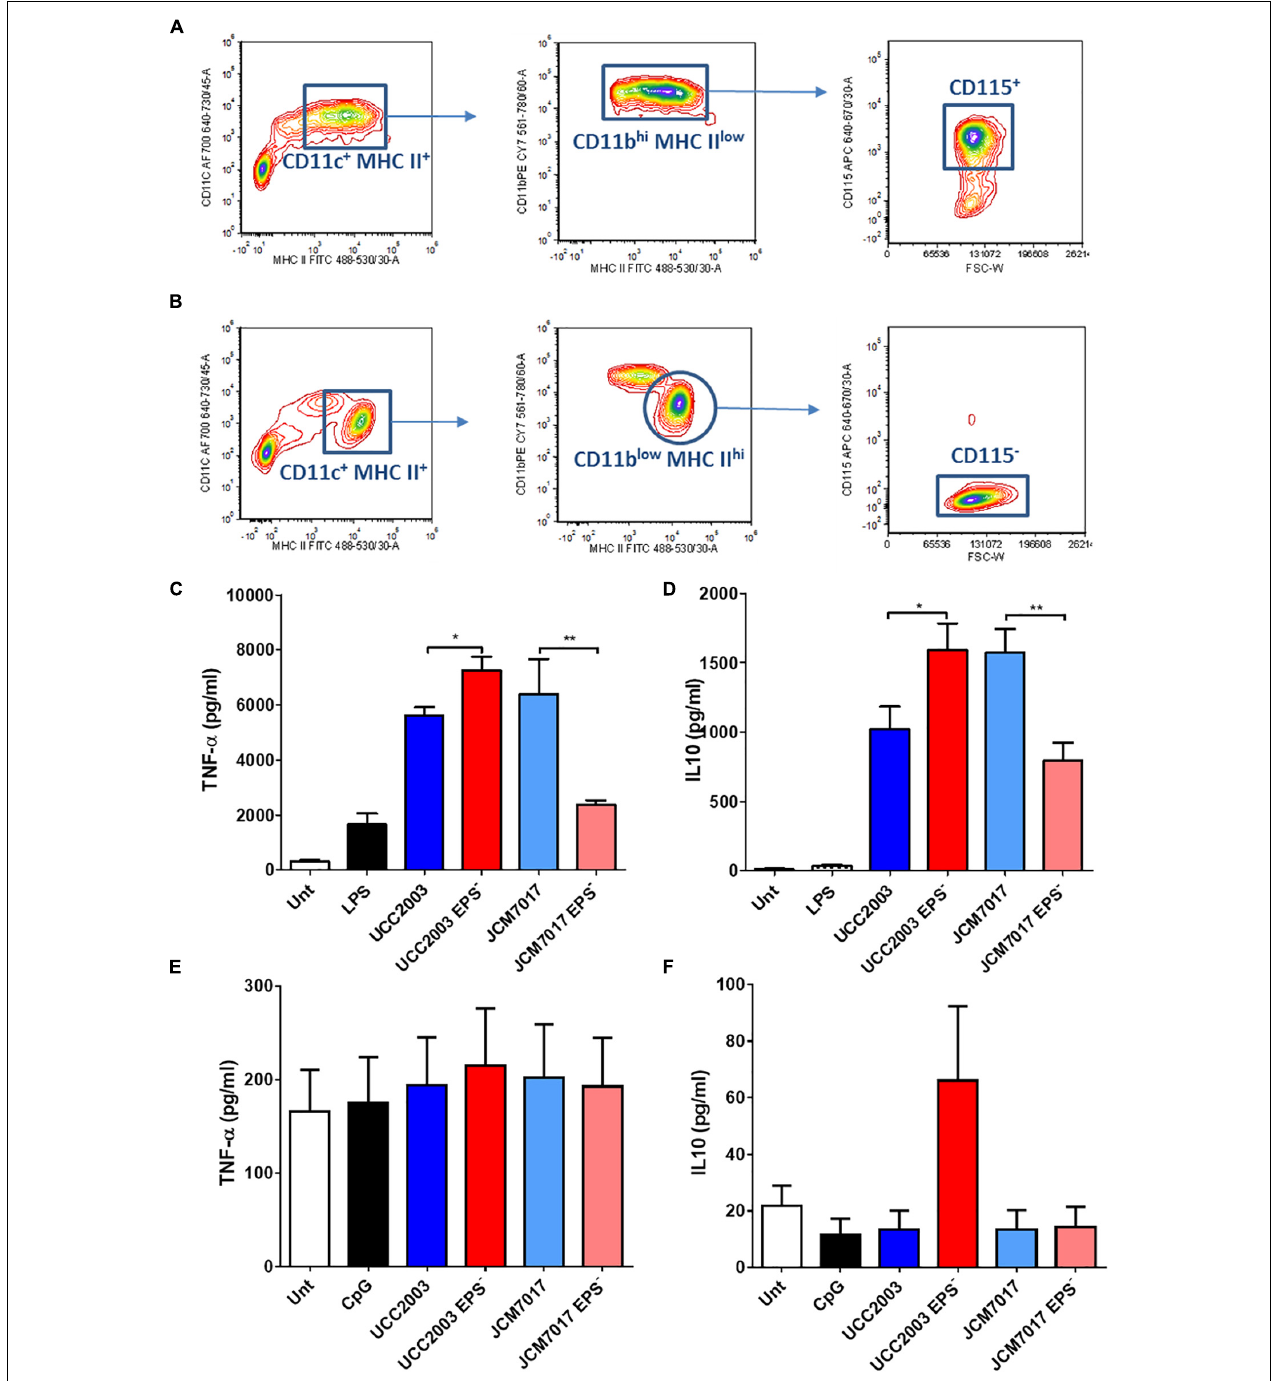
FIGURE 4 | Opposing effects of EPS on murine macrophage cytokine responses to B. breve strains. (A,B) Gating strategy to identify and sort BMDMs. The bone marrow cells were analyzed and sorted by multi-color flow cytometry. Cells were stained for MHC-II, CD11b, CD11c, and CD115. (A) For the adherent cells, MHC-II vs. CD11b contour plots were obtained by gating on MHC-II + CD11c + cells. Forward size scattered (FSC) vs. CD115 contour plots were obtained by gating on MHC-II low CD11b high cells. CD115 + cells were sorted and considered as pure macrophages population. (B) For the suspension cells MHC-II vs. CD11b contour plots were obtained by gating on MHC-II + CD11c + cells. FSC vs. CD115 contour plots were obtained by gating on MHC-II high CD11b low cells. CD115 − cells were sorted and considered as pure dendritic cells population. (C,D) TNF- α and IL10 secretion from BMDMs co-cultured with B. breve UCC2003, JCM7017 and their isogenic EPS − mutants. (E,F) TNF- α and IL10 secretion from BMDCs co-cultured with B. breve UCC2003, JCM7017 and their isogenic EPS − mutants. Cytokines were analyzed by ELISA. Data is the average of three independent experiments performed in triplicates. Statistical analysis was assessed using the student t -test in GraphPad Prism where * p -value < 0.05 and ** p -value < 0.005.